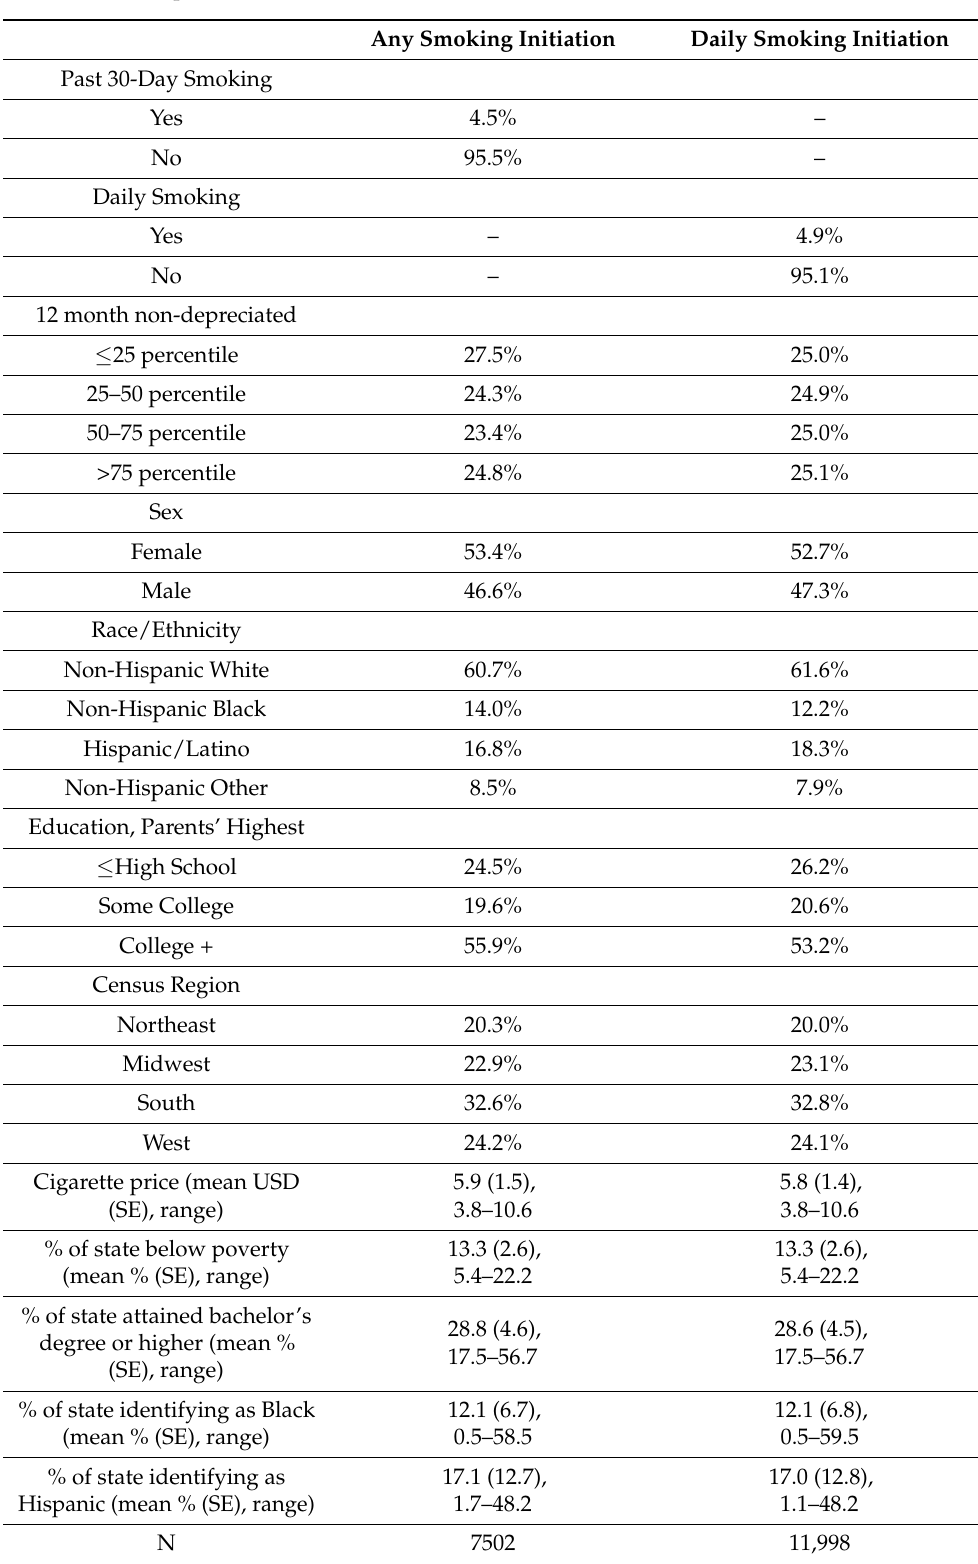
Table 1. Weighted descriptive statistics for smoking initiation and daily smoking initiation analytic samples at modal age 19/20, monitoring the future longitudinal sample, baseline year 2001–2015. Results reflect imputed data (m =